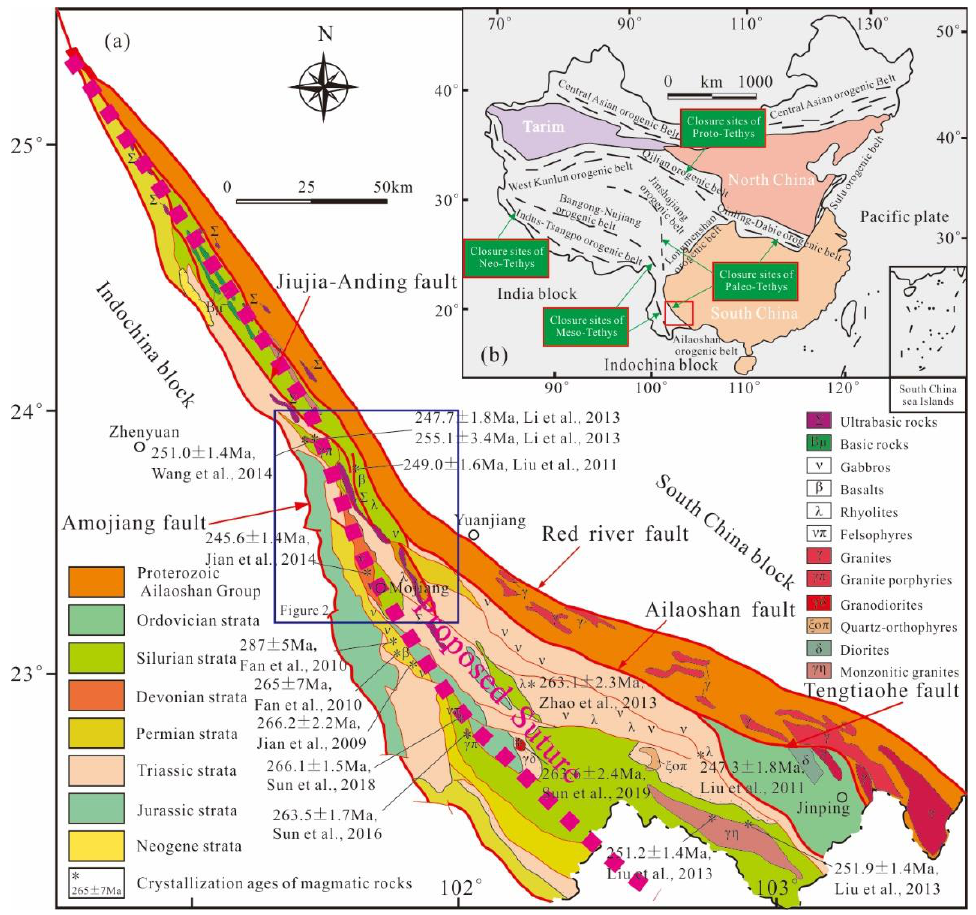
Figure 1. Temporal – spatial distribution of the magmatic rocks along the Ailaoshan orogenic belt ( a ) and the location of the study area in China ’ s tectonic map showing Precambrian blocks surrounded by Phanerozoic orogenic belts (( b ); modified from [28]).